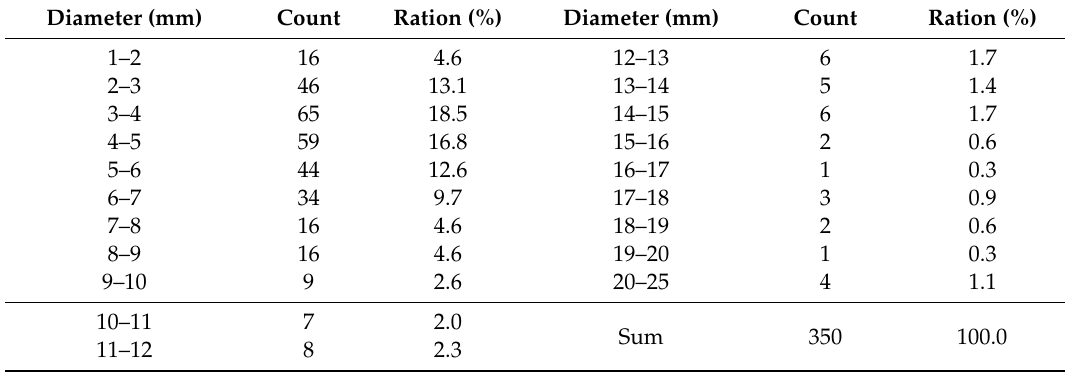
Table 3. Driftwood found near agricultural drainage ditches.